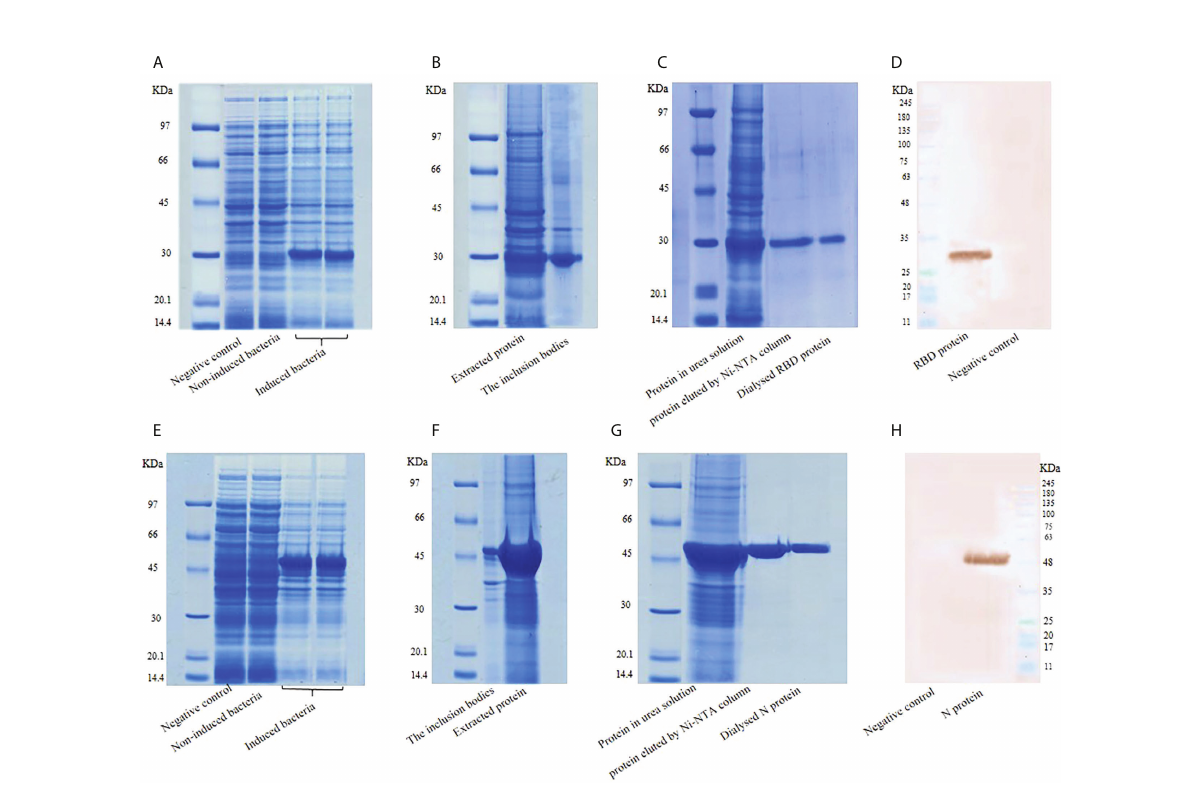
FIGURE 3 (A) Expression of RBD protein, (B) Extraction of RBD protein, (C) Puri fi cation and dialysis of RBD, (D) Western blot analysis of RBD. (E) Expression of N protein, (F) Extraction of N protein, (G) Puri fi cation of N protein, (H) Western blot analysis of N